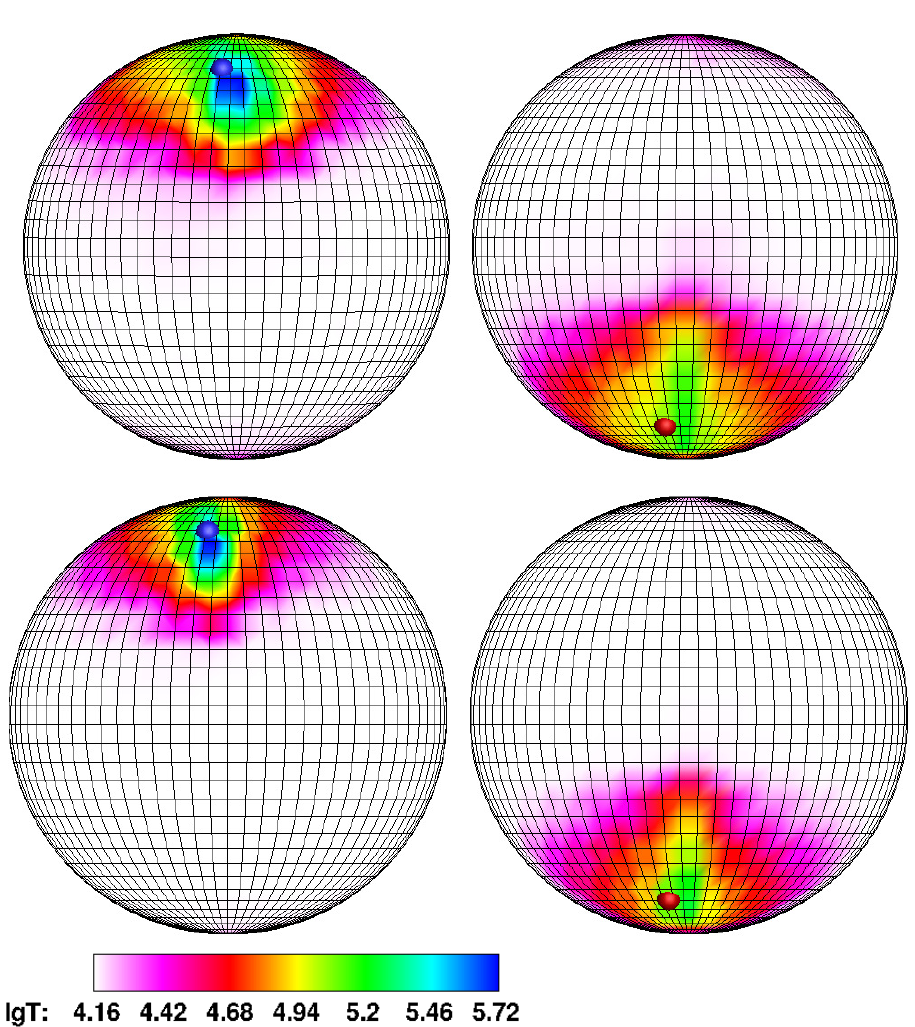
Figure 5. The same as in Figure 4, but for Model 3 ( upper panel) and Model 4 ( lower panel). In Figures 4 and 5, the calculated temperature distributions over the accretor surface for the same models as in Figures 2 and 3 are presented. For clarity, a grid with a step in longitude and latitude of 5 ◦ is applied to the surface of the accretor. The left